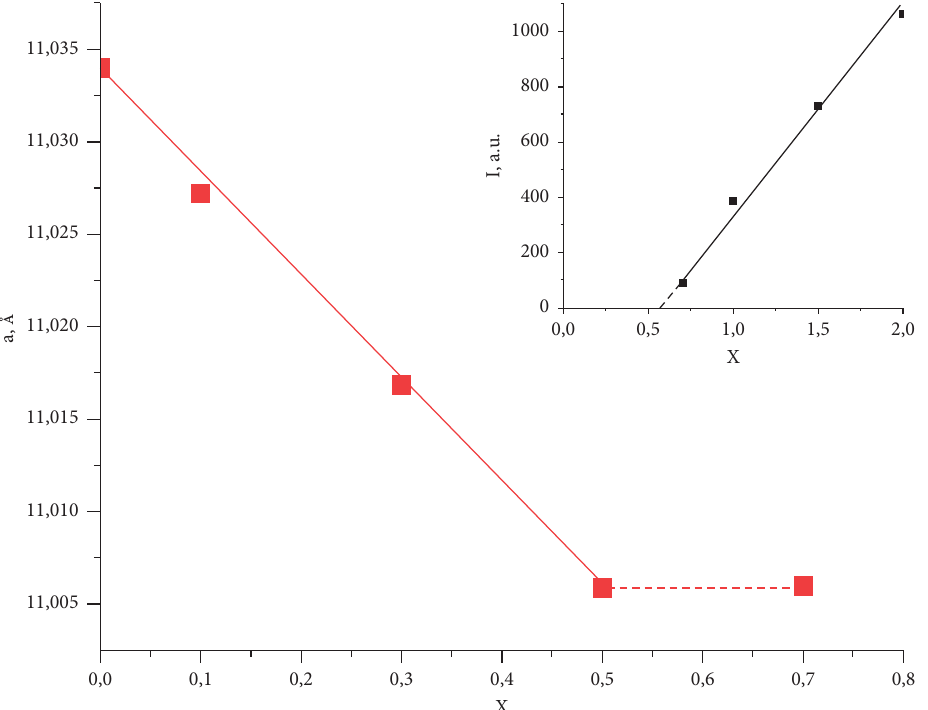
Figure 3: Cubic phase unit cell parameter variation with the Nd intensity on the series